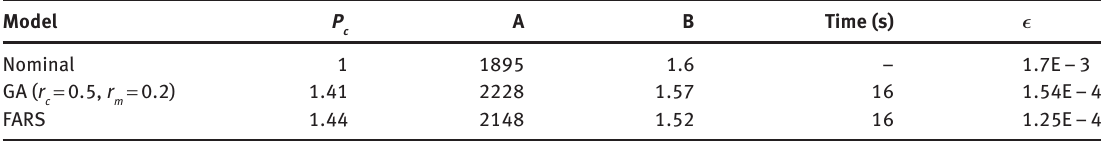
Table 4: Summary of Best Achievements of the Optimized Models for the Estimation of Carbon Content at the Endpoint in a Converter.